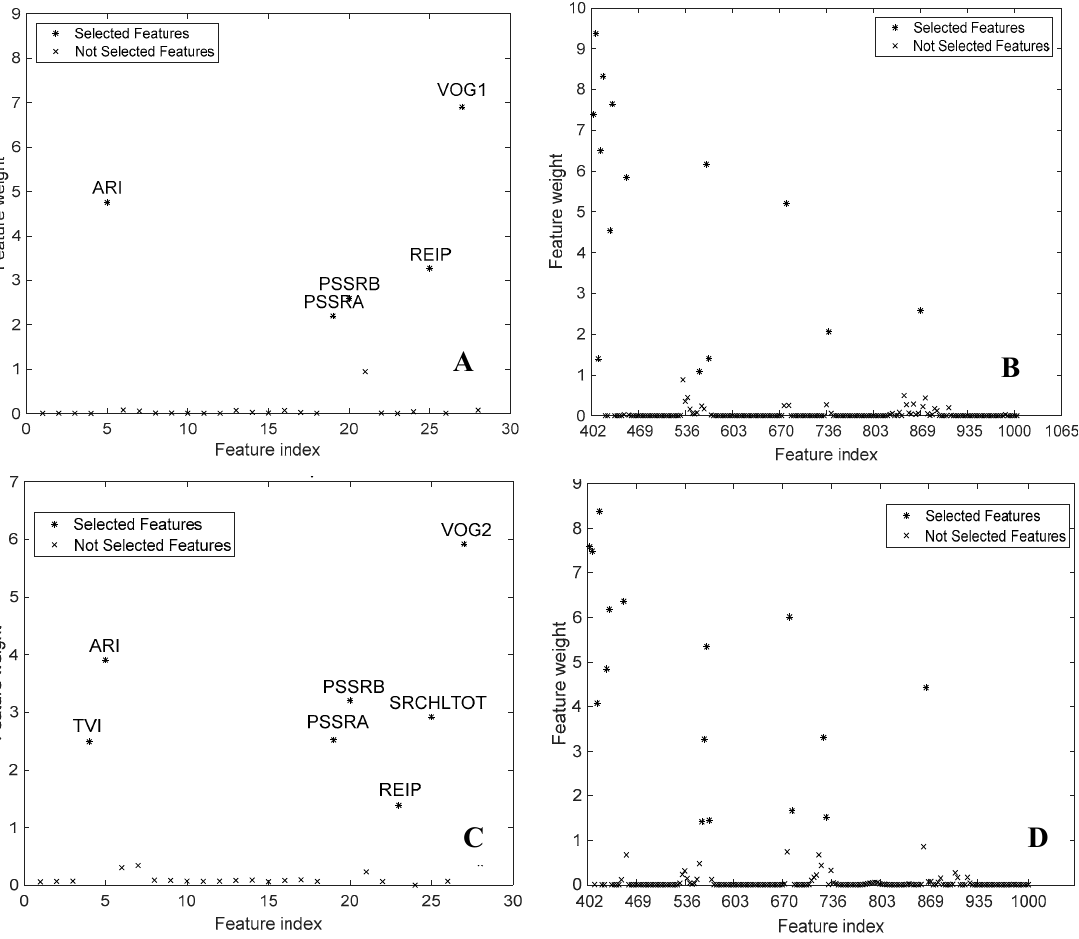
Figure 3. Vegetation indices ( A , C ) and e ff ective wavelengths ( B , D ) that were used as model features, as were selected by the neighborhood component analysis (NCA) algorithm before ( A , B ) and after ( C , D ) the outlier elimination. The threshold weight value of 1 was selected for the feature selection.